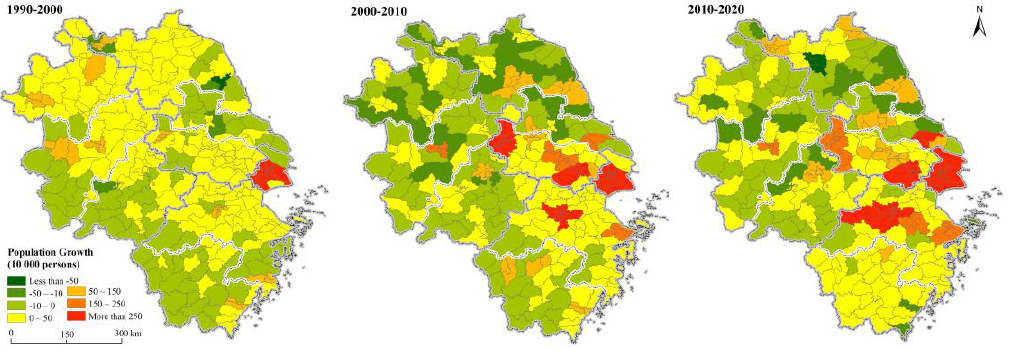
Figure 7. Changes in population spatial distribution from 1990 to 2020.